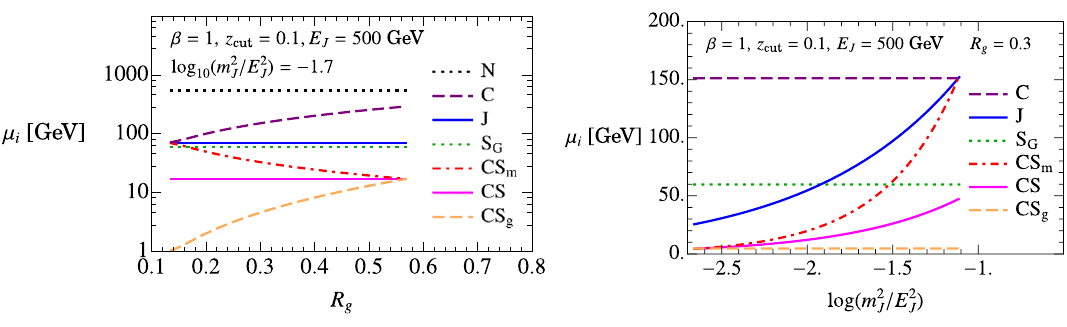
Figure 4 . Profile scales µ i as a function of the groomed radius at fixed jet mass (top left) and as a function of the mass at fixed radius (top right), for β = 1 . For more clarity the former plot uses a logarithmic scale, while we omit the hard scale µ N in the latter. At small groomed radii (large jet masses) µ cs and µ J merge into µ C , while at large radii (small masses) µ cs m a single soft-collinear scale µ cs , consistent with the mode picture.